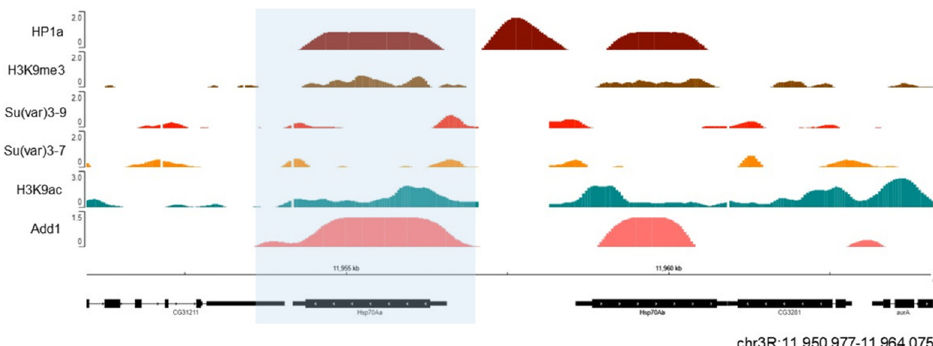
Figure 6. HP1a and dADD1 proteins co-localize at the Hsp70 locus. Previously published ChIP-seq data on S2 cells were used, where we see HP1a (dark red), dADD1 (salmon) HP1a, Su (var) 3-9 (light red), Su (var) 3-7 (orange), H3k9me3 mark (brown), and H3k9ac (green). At the bottom are the gene Hsp70 Aa (blue box) and its location, with the reference in kilobases.